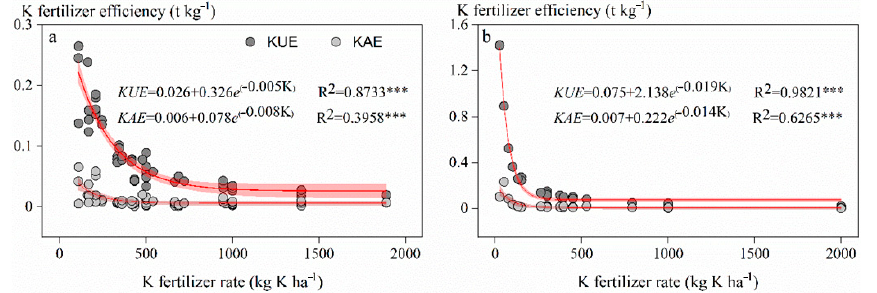
Figure 4. K use efficiency (KUE) and agronomic efficiency of K (KAE) in apple-growing regions of ( a ) China’s Loess Plateau and ( b ) Bohai Bay. *** indicates significance at the 0.001 level.